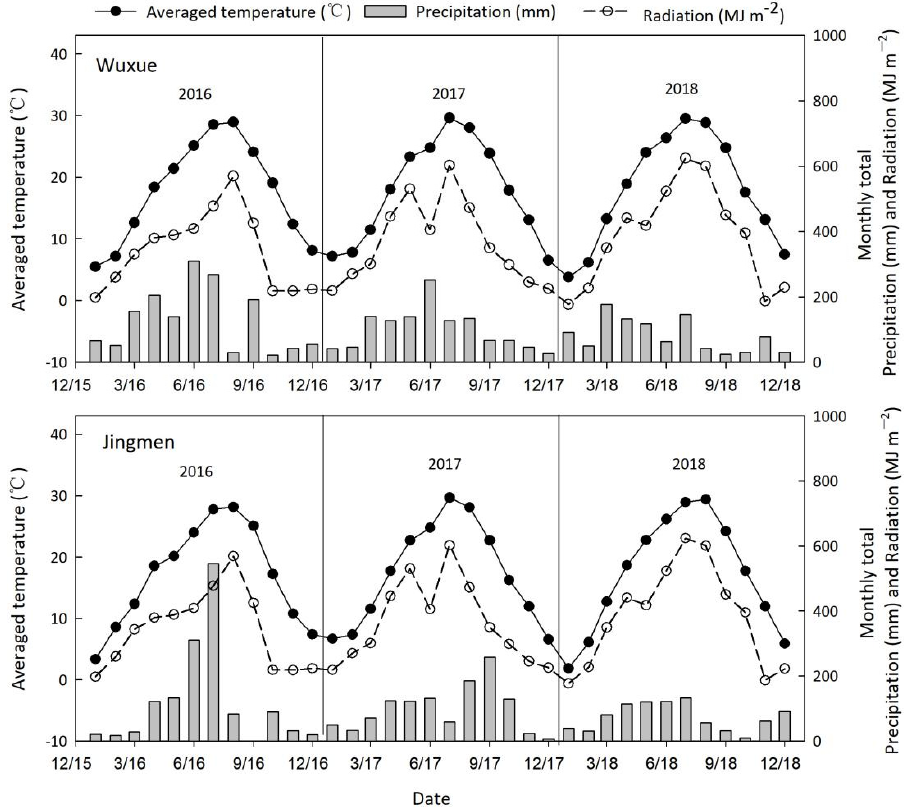
Figure 1. Monthly averaged temperature and total precipitation and radiation at Wuxue and Jing- men from 2016 to 2018. from 2016 to